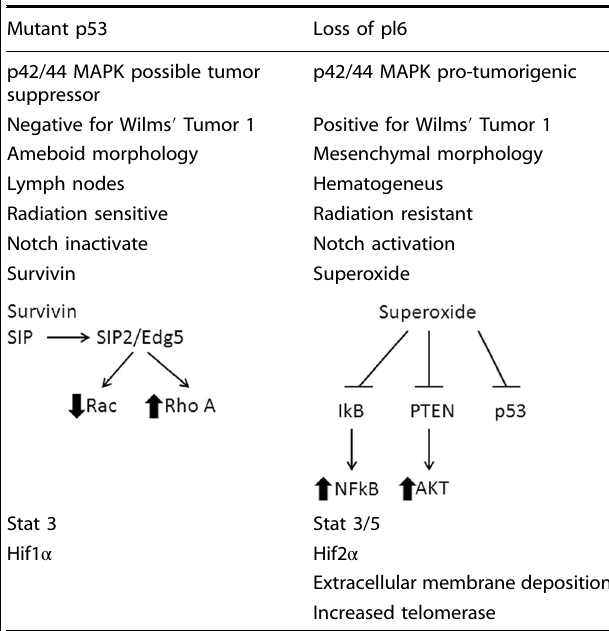
Table 1. Signaling differences and mutations in tumors that